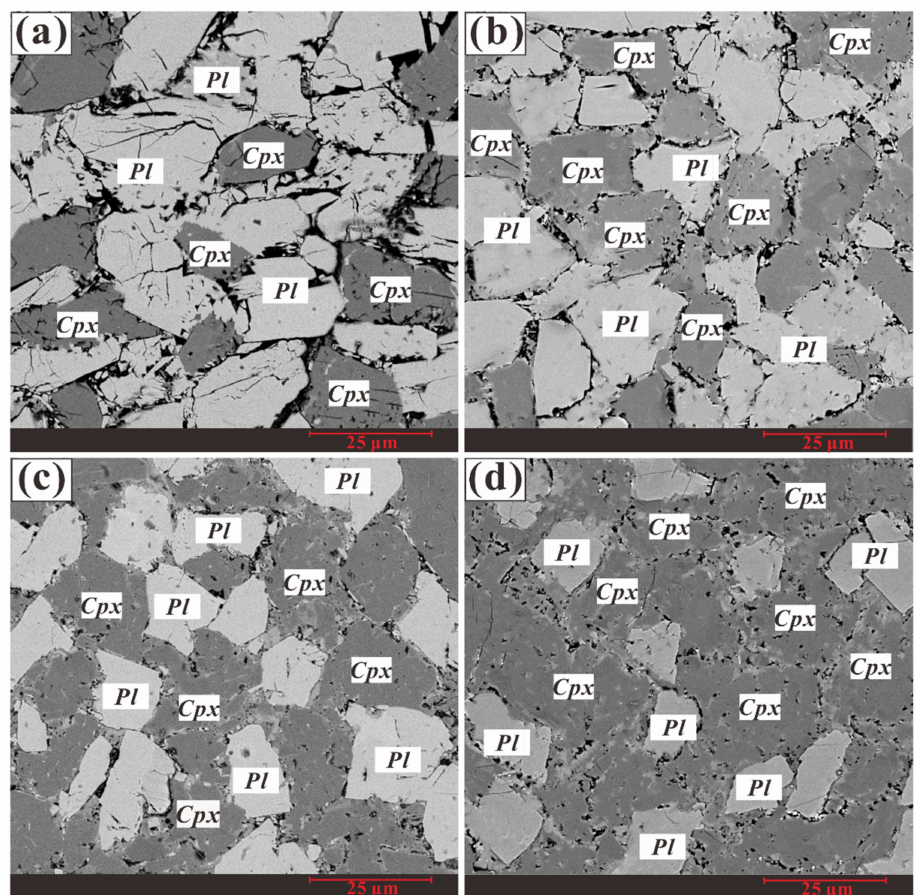
Figure 1. Four representative backscattered electron images of dry hot-pressed sintering gabbro by using scanning electron microscope with different mineralogical proportions: ( a ) Cpx 20 Pl 80 , ( b ) Cpx 40 Pl 60 , ( c ) Cpx 60 Pl 40 , and ( d ) Cpx 80 Pl 20 . Cpx and Pl represent clinopyroxene and plagioclase,